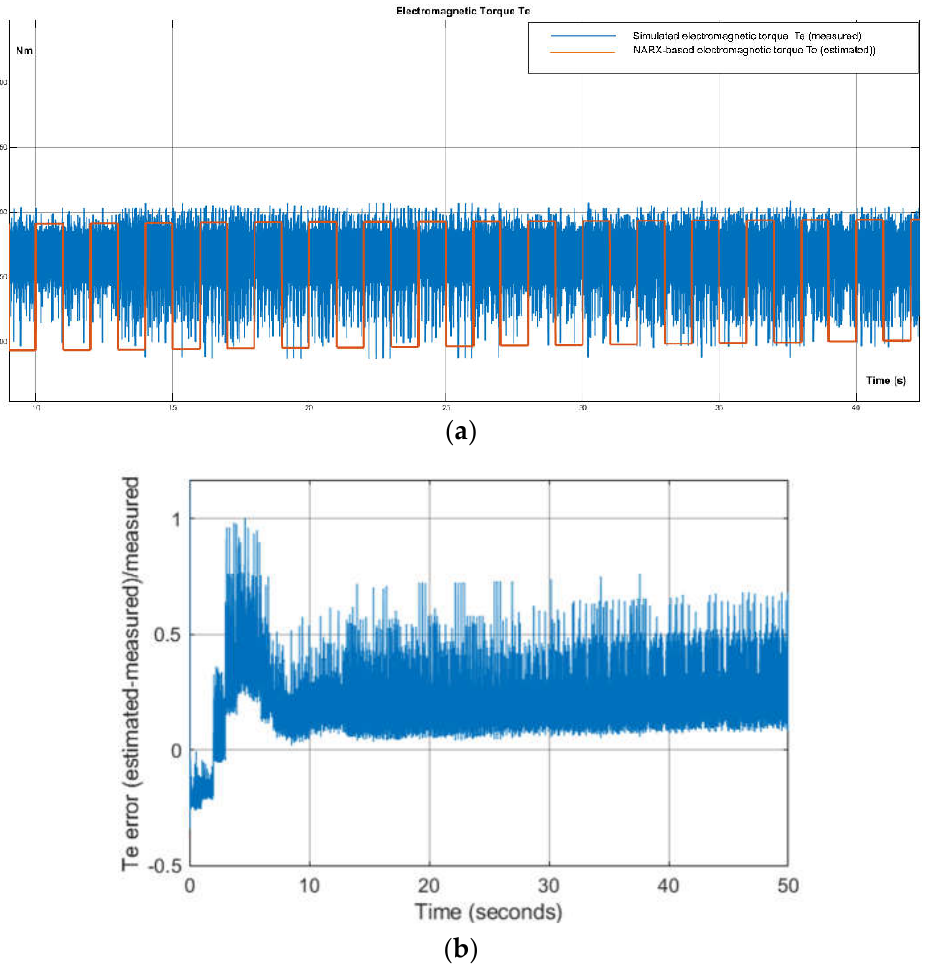
Figure 24. ( a ) Electromagnetic torque (orange) M e , measured for training. M e estimated (blue) by the narx-based predictor; ( b ) M e error (scaled to 1.0) between measured and estimated electromagnetic torque for the rotor.